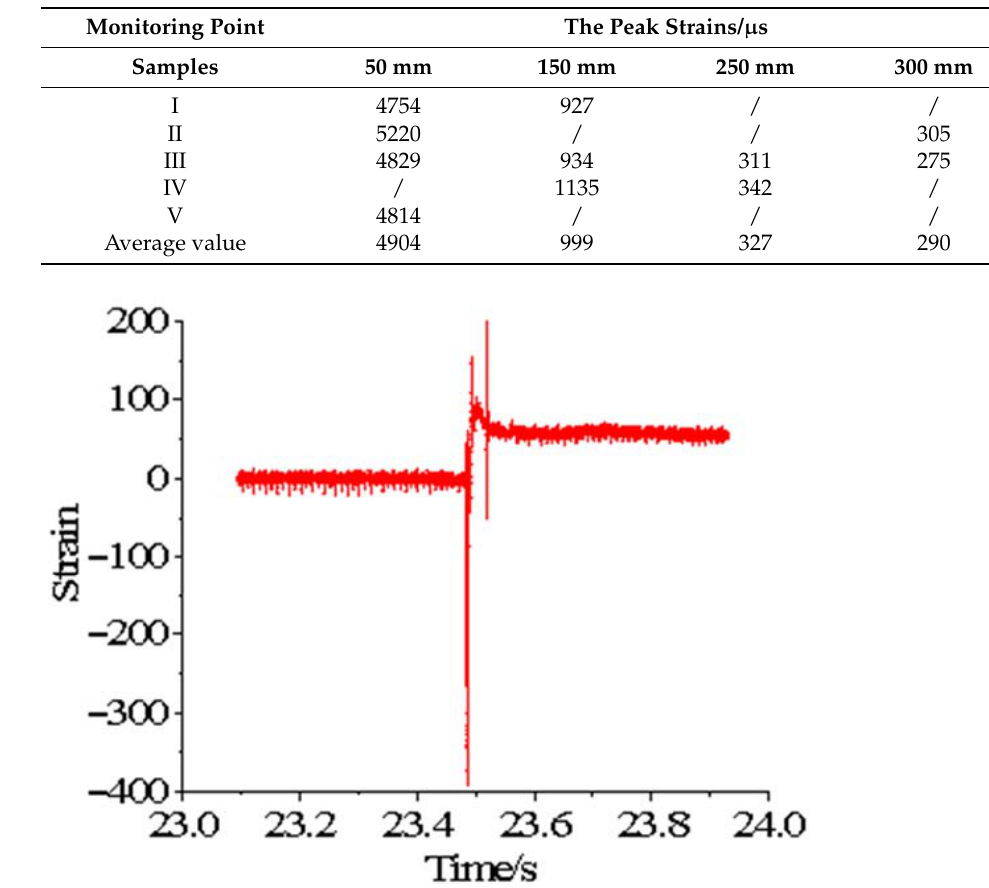
Figure 15. Strain wave of coal mass specimen induced by HPAB.